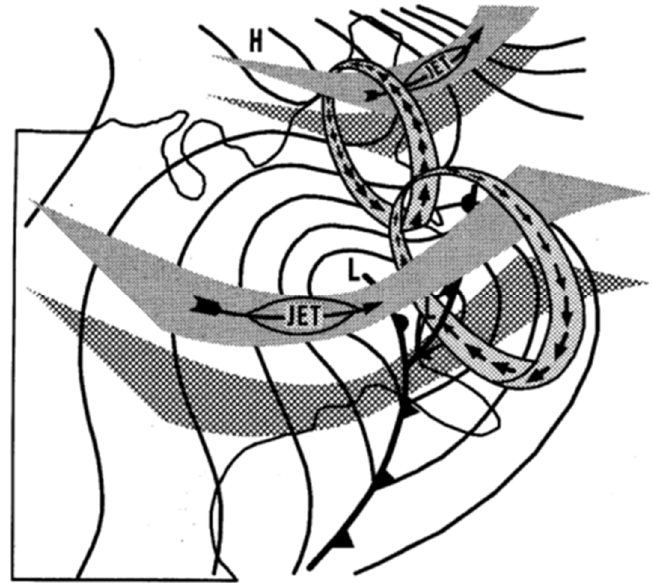
Figure 1. Three-dimensional schematic of jet-related circulation patterns during East Coast snowstorms. The transverse circulations are associated with diffluent exit and entrance regions of jet streaks embedded, respectively, at the bases of troughs moving across the Ohio and Tennessee valleys and across southeastern Canada. Surface low and high pressure systems, isobars, and frontal positions are also included (reproduced from [2]).